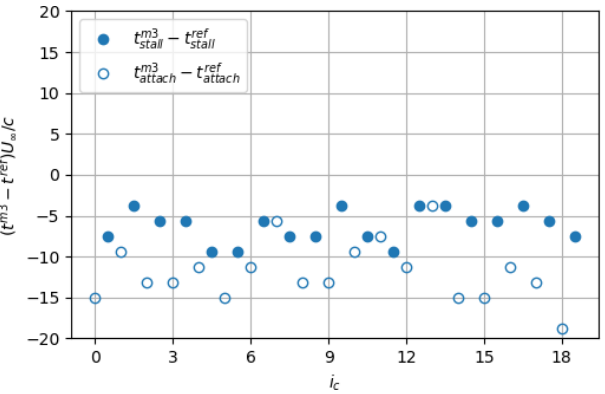
Figure 20. Results of the zero-crossing method to extract the flow stall–reattachment instants using the third method. The filled circle symbols correspond to stall instants, t m 3 bols correspond to reattachment instants, t m 3